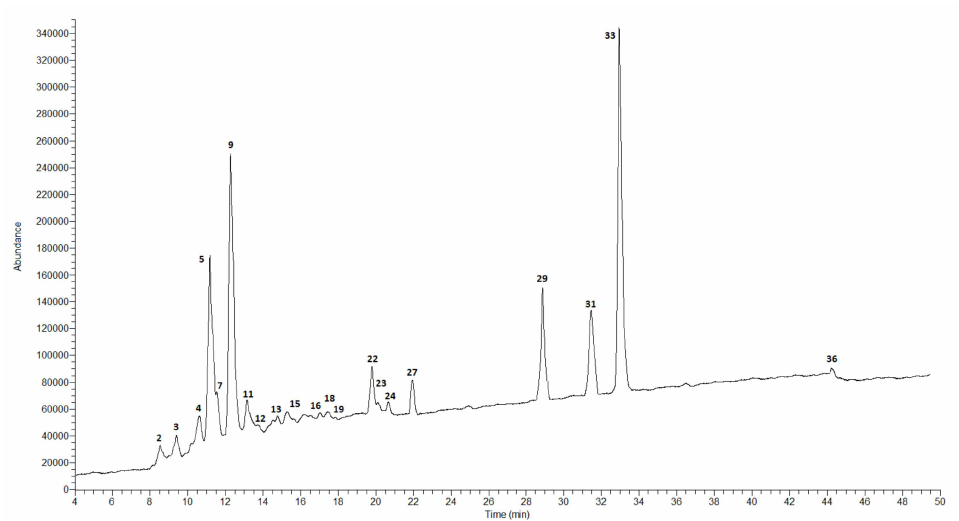
Figure 2. LC-MS chromatogram in SCAN mode for 60% ethanol extract from the fruits of C. nebrodensis